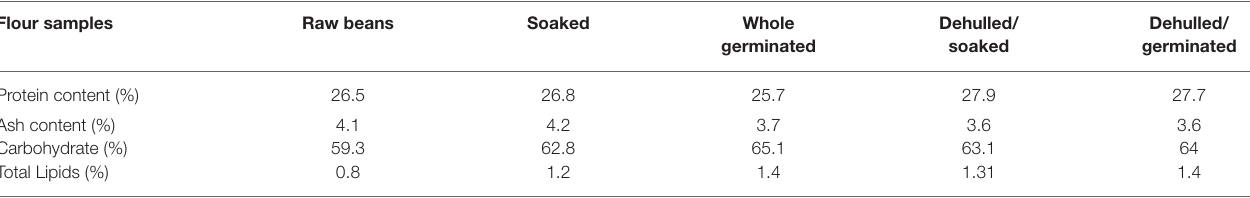
TABLE 1 | Ash and protein content of flour samples generated from treated and untreated yellow eye (YE) beans. Flour samples Raw beans Soaked Whole